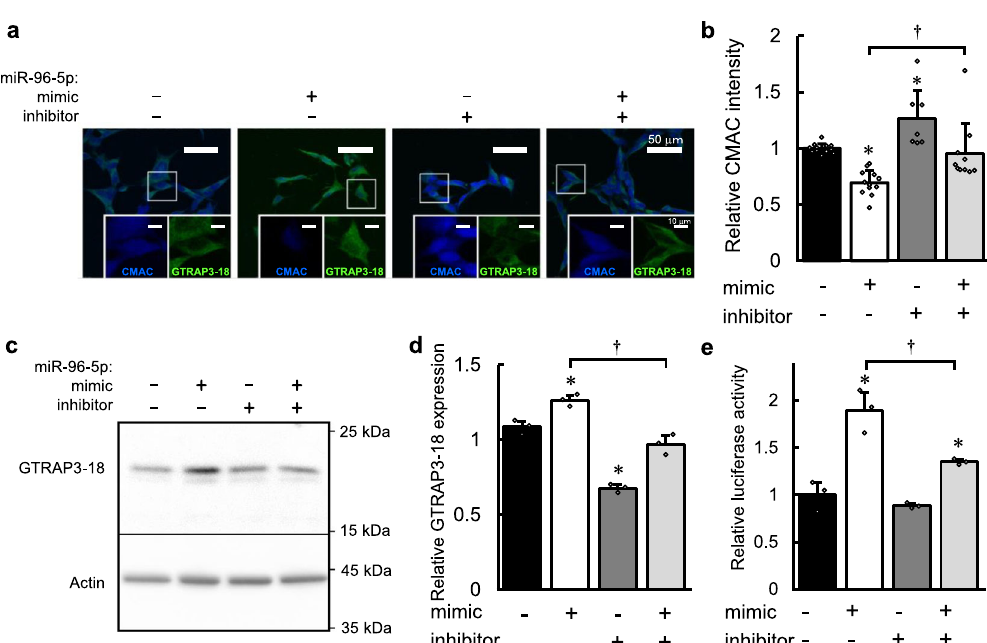
Fig. 1 The effect of miR-96-5p on GSH level and GTRAP3-18 expression. a Confocal images show the effect of the miR-96-5p mimic and/or inhibitor transfection on the intensity of CMAC as a marker of GSH (blue) and the expression of GTRAP3-18 (green). Scale bar, 50 μ m. Insets in panels are enlarged images corresponding to the box highlighted on the full images. Scale bar, 10 μ m. b Quanti fi cation of the relative CMAC density in a is shown. Data are mean values ± SD obtained from independent samples and individual data points are plotted ( n = 12 for negative control or miR-96-5p mimic, n = 7 for miR-96-5p inhibitor and n = 10 for both miR-96-5p mimic and inhibitor transfection). Data were analyzed by one-way ANOVA ( F (3,37) = 14.345, p = 0.0000023) and Tukey ’ s HSD test. * p < 0.05 relative to the negative control. † p < 0.05 versus the effect of the miR-96-5p inhibitor. c The endogenous expressions of GTRAP3-18 and β -actin in Neuro2a cells with transfection of miR-96-5p mimic and/or inhibitor are shown. Molecular weight markers are depicted at right. Full blots are presented in Supplementary Fig. 12. d Quanti fi cation of the data in panel c by densitometry. Data represent mean values ± SD obtained from three independent experiments and individual data points are plotted. Data were analyzed by one-way ANOVA ( F(3,8) = 79.74, p = 0.0000027) and Tukey ’ s HSD test. * p < 0.05 relative to the negative control. † p < 0.05 versus the effect of the miR-96-5p inhibitor. e Relative luciferase activity in SH-SY5Y cells transfected with the luciferase plasmid of GTRAP3-18 3 ′ -UTR with the miR-96-5p mimic and/or inhibitor is shown. Data represent mean values ± SD obtained from three individual experiments and individual data points are plotted. Data were analyzed by one-way ANOVA( F (3,8) = 31.27, p = 0.000091) and Tukey ’ s HSD test. * p < 0.05 relative to the negative control. † p < 0.05 versus the effect of the miR-96-5p